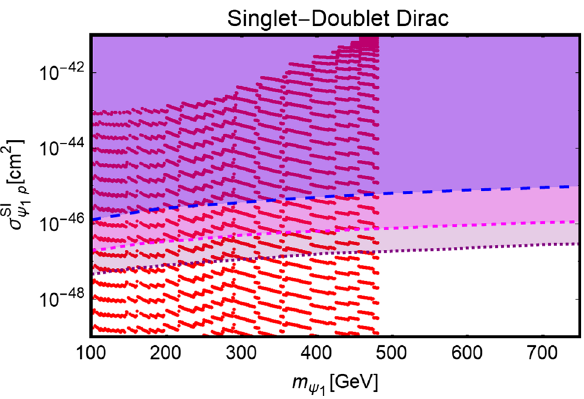
Fig. 26 Model points (red) for the Singlet-Doublet Dirac fermion DM model, generated through a scan over the M N , M L , y 1 , y 2 parame- ters (see main text), having the correct DM relic density in the bi- ,σ SI ) . The blue, magenta and purple regions dimensional plane ( m ψ ψ 1 p 1 correspond to the present as well as projected exclusions by XENON1T and LZ,